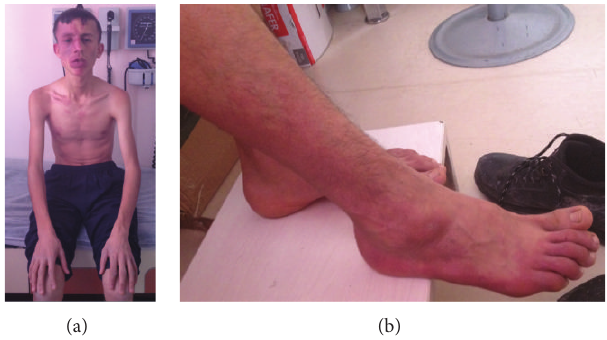
Figure 2: Port-wine stains over the right side of his face, ankle (a), and toes